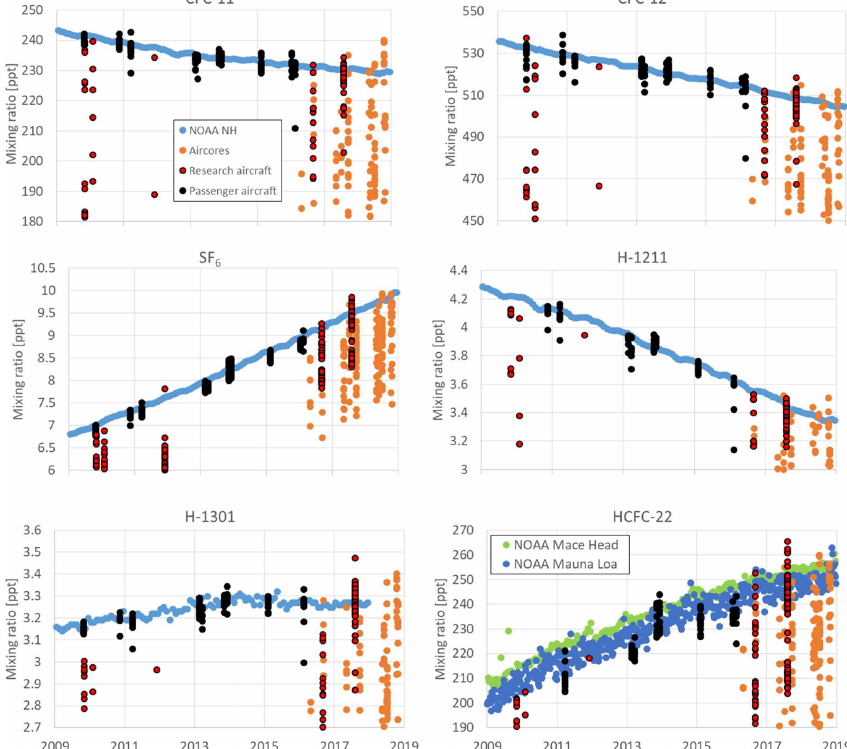
Figure 1. Aircraft- and balloon-based mixing ratios of six halogenated trace gases in the upper troposphere and stratosphere as compared to the NOAA/GMD ground-based northern hemispheric GGGRN time series (https://www.esrl.noaa.gov/gmd/, last access: 11 January 2020). HCFC-22 has a significant sink process in the troposphere and therefore exhibits stronger inner-hemispheric gradients. To illustrate that, we compare the mid-latitude station at Mace Head, Ireland, with the subtropical station at Mauna Loa, Hawaii. Lower mixing ratios generally represent higher altitudes. For all gases except SF 6 , some higher-altitude data are not shown to better demonstrate the good comparability of near-tropopause data to the NOAA time series. The complete corresponding data including uncertainties can be found in the Supplement (see also Figs. S1 to